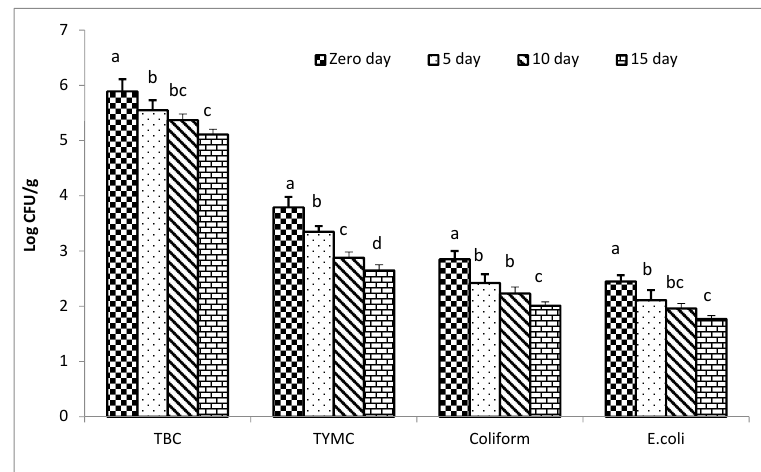
Figure 2. Effects of green coffee extract on total bacterial count (TBC), total yeasts and molds count (TYMC), coliform and Escherichia coli populations in the basal diet during finisher feeding of broilers. Ileum and cecum : The microbial load (total bacterial count, total yeasts and molds count, Escherichia coli, Enterococcus spp., and Salmonella spp . ) in the broiler cecum was reduced by elevating